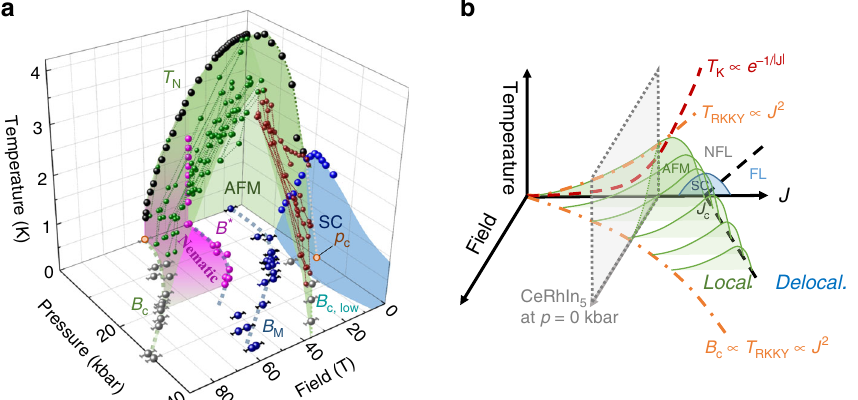
Fig. 7 Schematic ( p , B , T ) phase diagram of CeRhIn 5 . a Experimental phase diagram of CeRhIn 5 . B * , B M , and B c,low denote the nematic, metamagnetic, and magnetic transition fi elds and B c the AFM suppression fi eld reported in this work. p c marks the putative QCP at 23 kbar (for the zero-temperature ( p , B ) phase diagram see also Supplementary Fig. 11). b Sketch of the ( J , T ) phase diagram according to Doniach et al. 42 , extended by the fi eld axis according to our experimental fi ndings (see “ Discussion ”